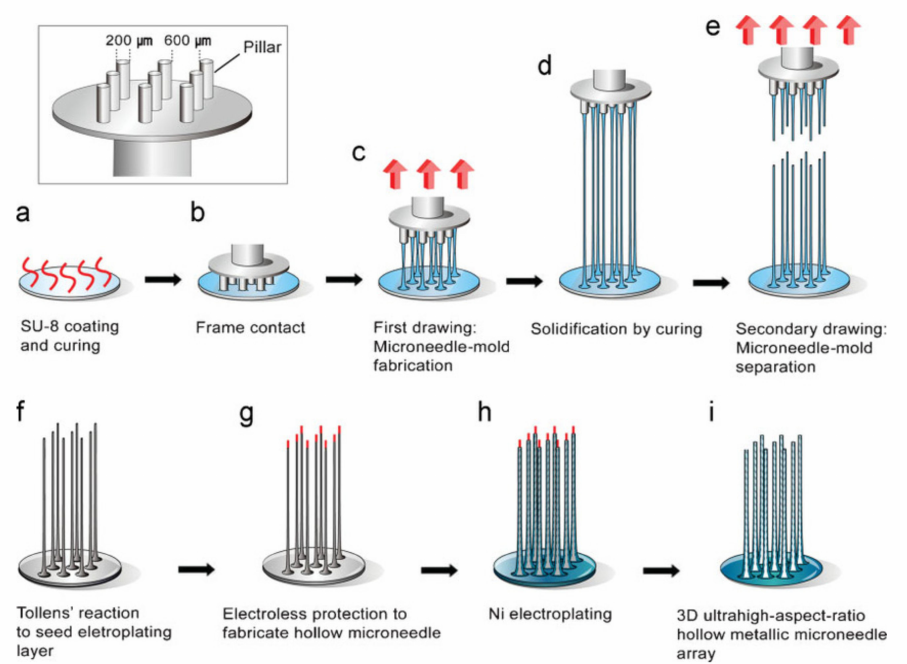
Figure 12. Drawing lithography to produce a 3D UHAR MN. The inset shows a drawing system with patterned pillars for drawing lithography. Stainless drills with a diameter of 200mm and a length of 3 mm were used as pillars and fixed in a 3 × 3 array on a PDMS frame. ( a ) The SU-8 2050 photoresist was spin coated and cooled. ( b ) After the photoresist contacted the patterned pillar, drawing lithography was performed. ( c ) Drawing caused the appearance of an extended conical-shaped bridge between the substrate and pillar. ( d ) The desired UHAR micro-needle mold was cured to generate a rigid structure. ( e ) The separation of the 3D microstructure bridge produced a solid MN mold. ( f ) Chemical deposition on the solid MN molds. ( g ) The upper portion of the MN mold was coated with electroless material using a drawing system. ( h ) Nickel electroplating on conducted solid MN molds. ( i ) The hollow metallic MN array was created upon elimination of the electroless protection and the photoresist MN mold [145]. Reproduced with permission from Kwang Lee et al., Drawing Lithography: Three-Dimensional Fabrication of an Ultrahigh-Aspect-Ratio MN; published by John Wiley and Sons, 2010. Copyright © 2021 WILEY-VCH Verlag GmbH & Co. KGaA,